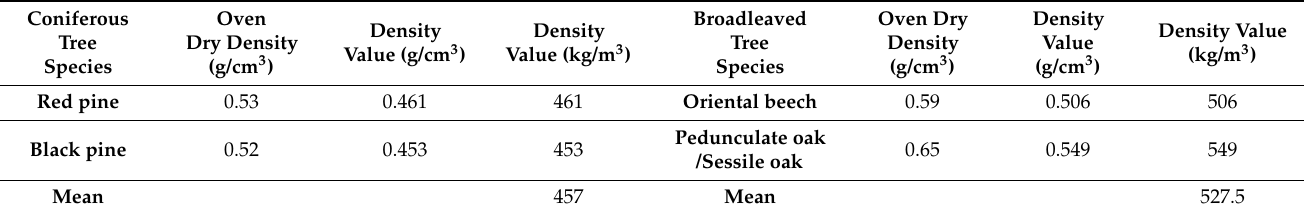
Table 12. Density values for tree species.